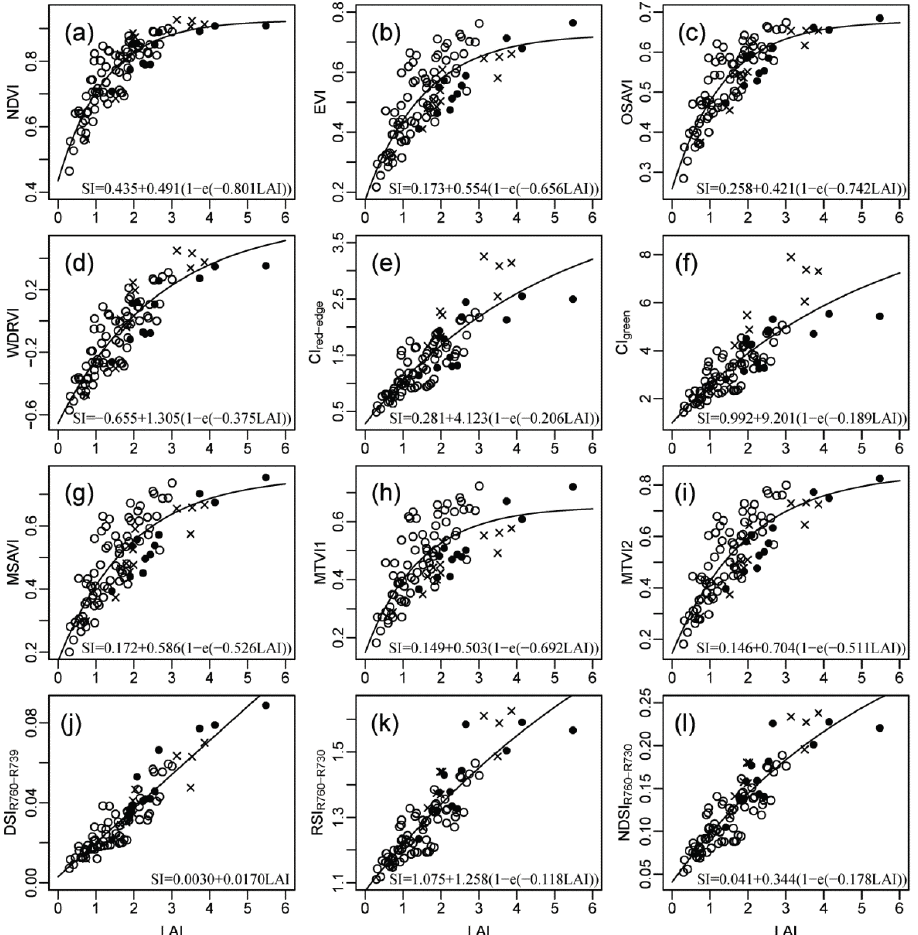
Figure 3. Relationships between LAI and (a) NDVI, (b) EVI, (c) OSAVI, (d) WDRVI, (e) CI red-edge , (f) CI green , (g) MSAVI, (h) MTV1, (i) MTV2, (j) DSI R760–R739 , (k) RSI R760–R730 , and (l) NDSI R760–R730 . Open circles, filled circles, and crosses indicate data from the cv. “Norin 61” in 2006, cv. “Norin 61” in 2007, and cv. “Iwainodaichi” for 2007, respectively. Solid lines indicate the best-fitted